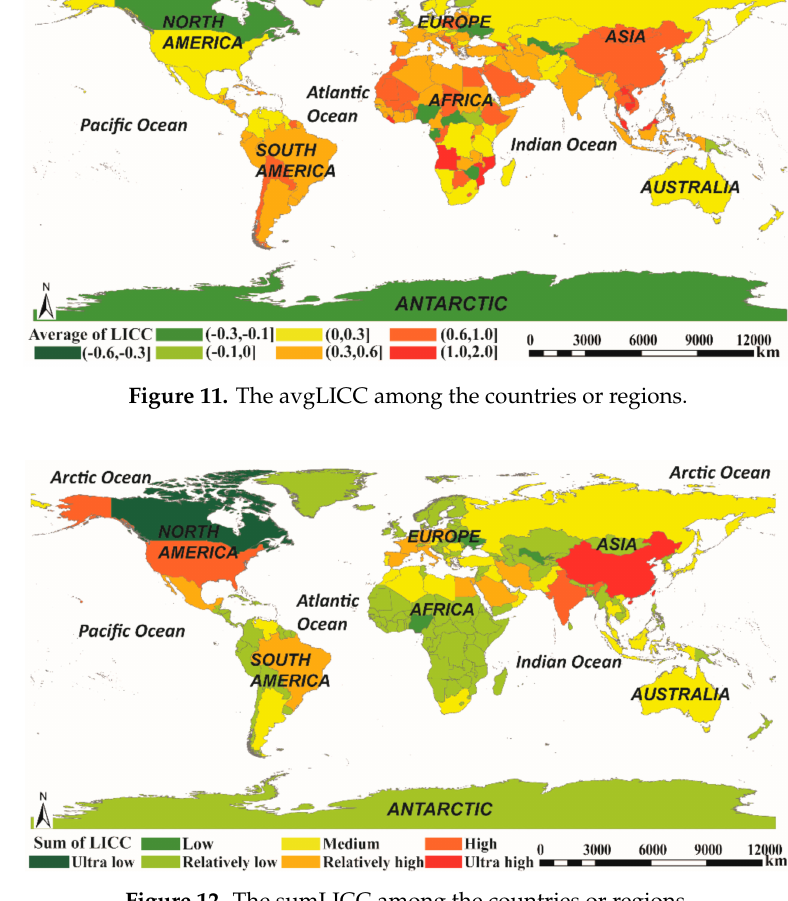
Figure 12. The sumLICC among the countries or